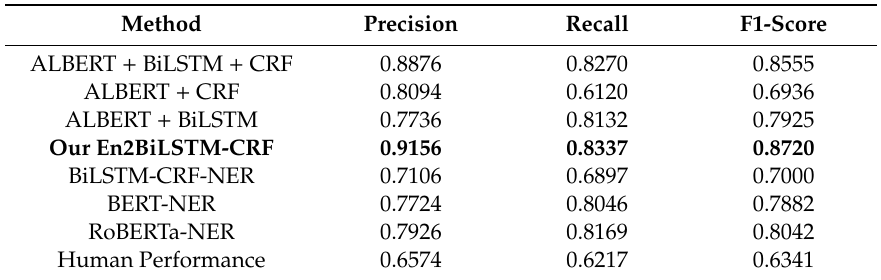
Table 3. Comparison with di ff erent baselines on CLUENER2020.